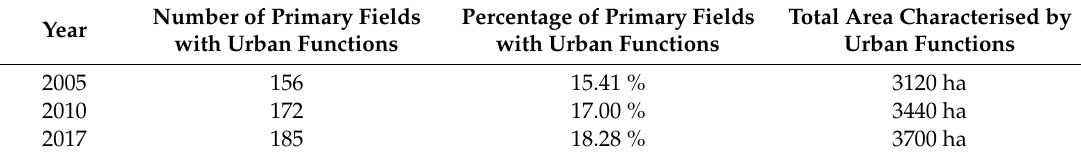
Table 2. The degree of membership in the set of urban functions in the interval [0.50–1.00] in each year of the study. Number of Primary Fields Percentage of Primary Fields Year with Urban Functions with Urban Functions